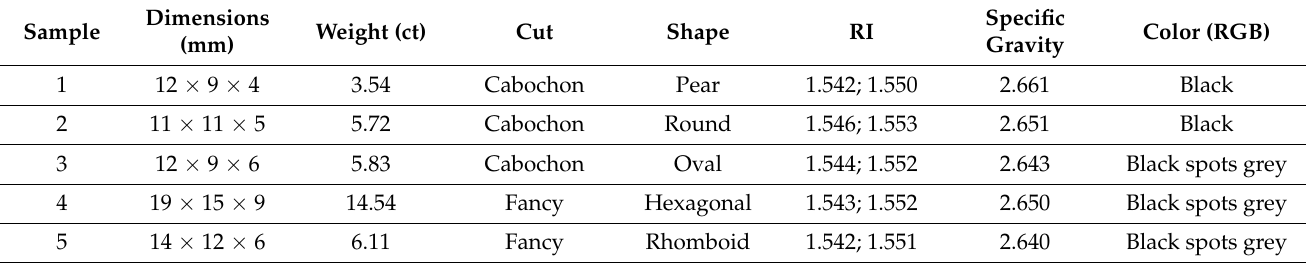
Table 1. Gemological properties of black quartz from the Burano